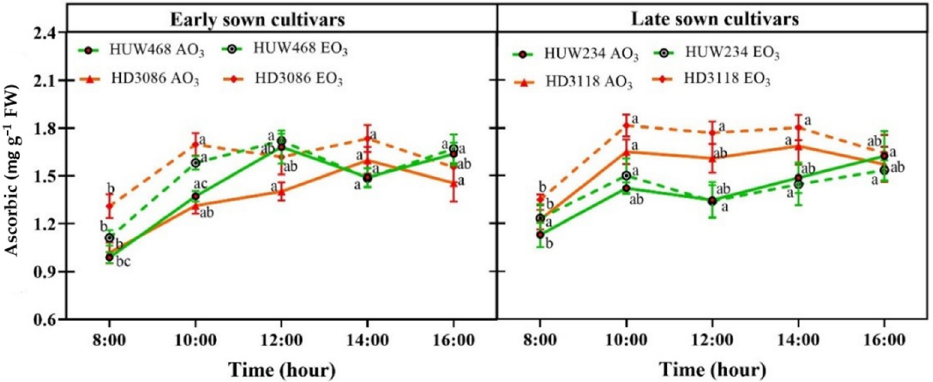
Figure 5. Diurnal changes in the ascorbic acid content of flag leaves in early (HUW468 and HD3118) and late sown (HUW234 and HD3118) wheat cultivars under ambient and elevated O 3 treatments. The letters on top of the line graph are based on the Tukey test among the 5 different time intervals of a day. Lines without the same letter are significantly different from each other at p < 0.05. Values are mean ± SE; N = 5 replicate leaves of 5 plants for each treatment. Solid lines represent plant response under ambient O 3 condition and dotted lines indicate plant response under elevated O 3 con- dition. Different color in a box represents different cultivar.